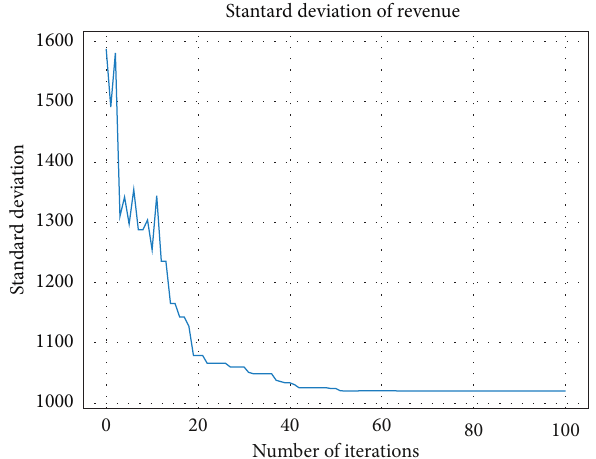
Figure 11: Standard deviation of revenues.